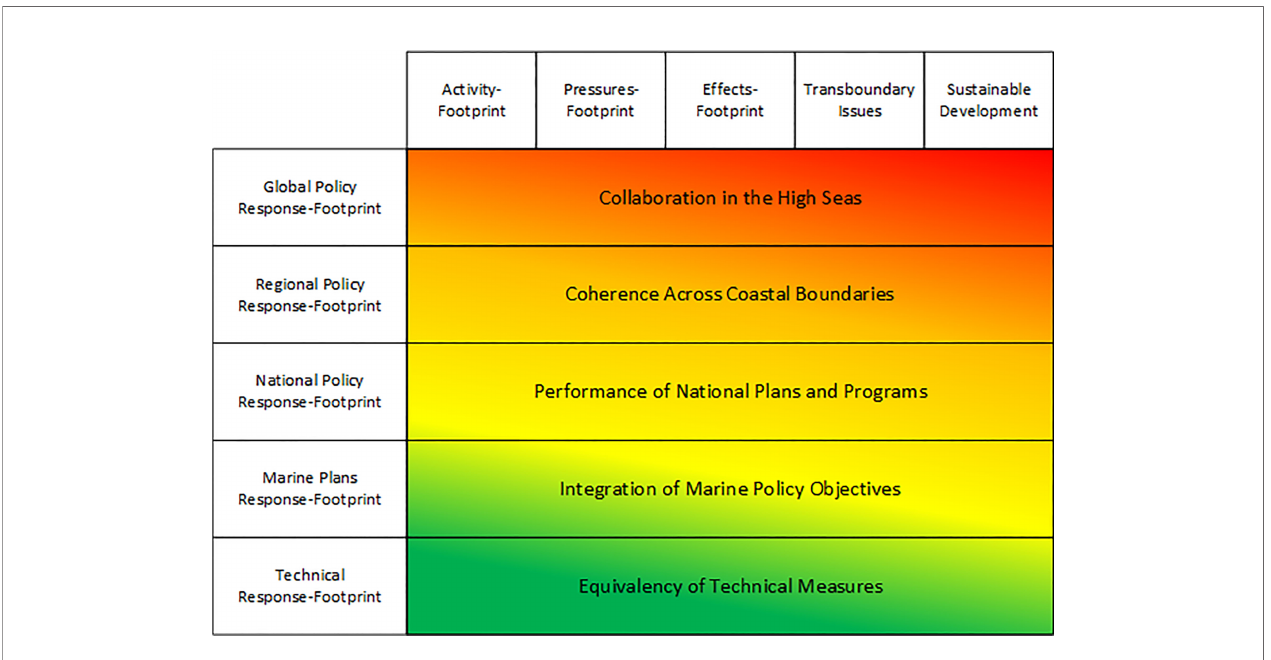
FIGURE 4 | Factors affecting the ef fi cacy of the